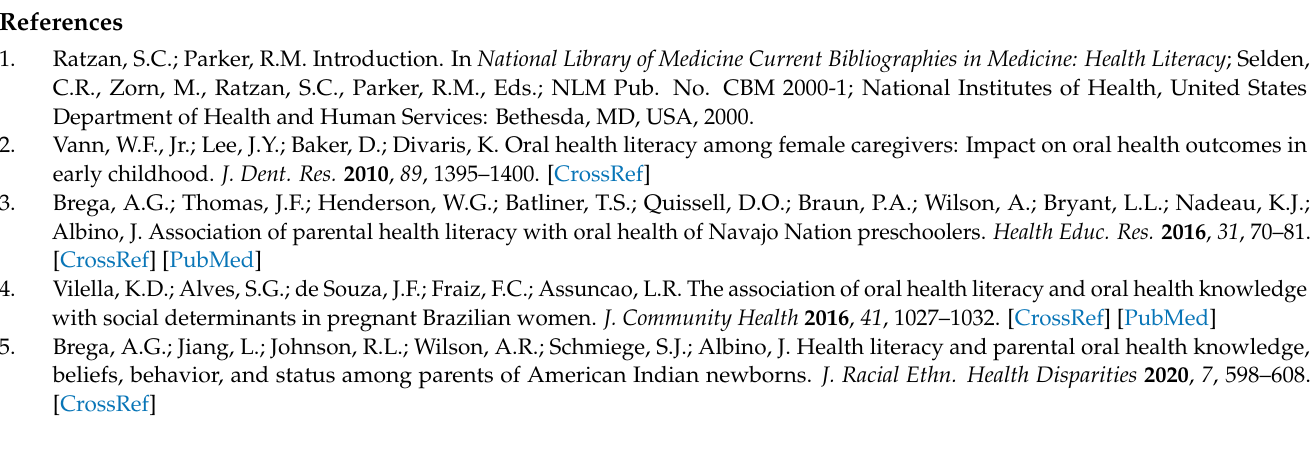
Table S2. Baseline Health Literacy (HL) as a Predictor of Change over Time in the Oral Health Constructs—Complete